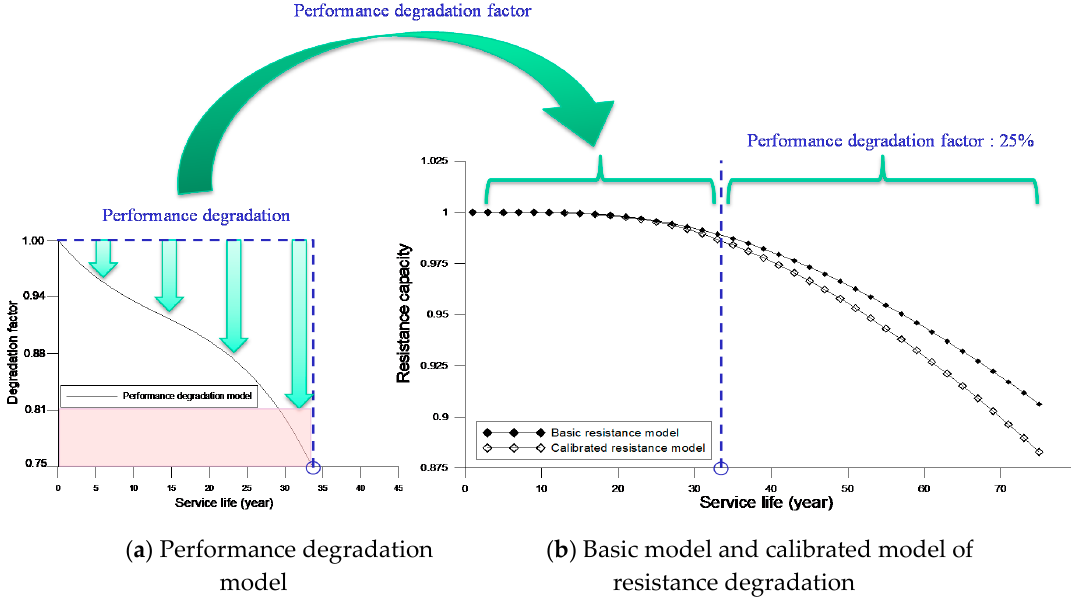
Figure 5. Calibration resistance model with performance degradation model.